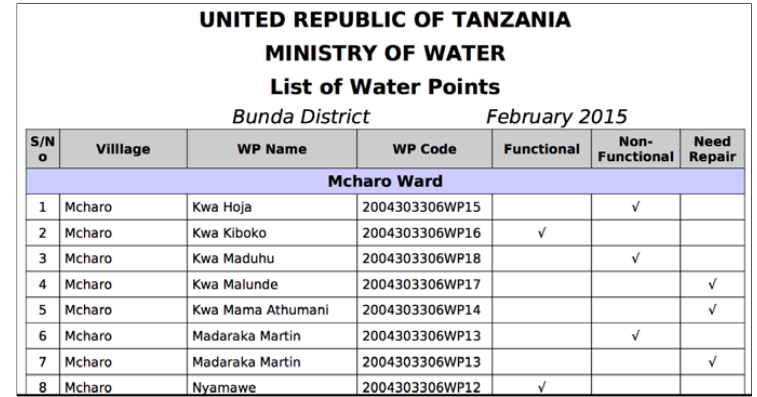
Figure 5. SEMA standard report.